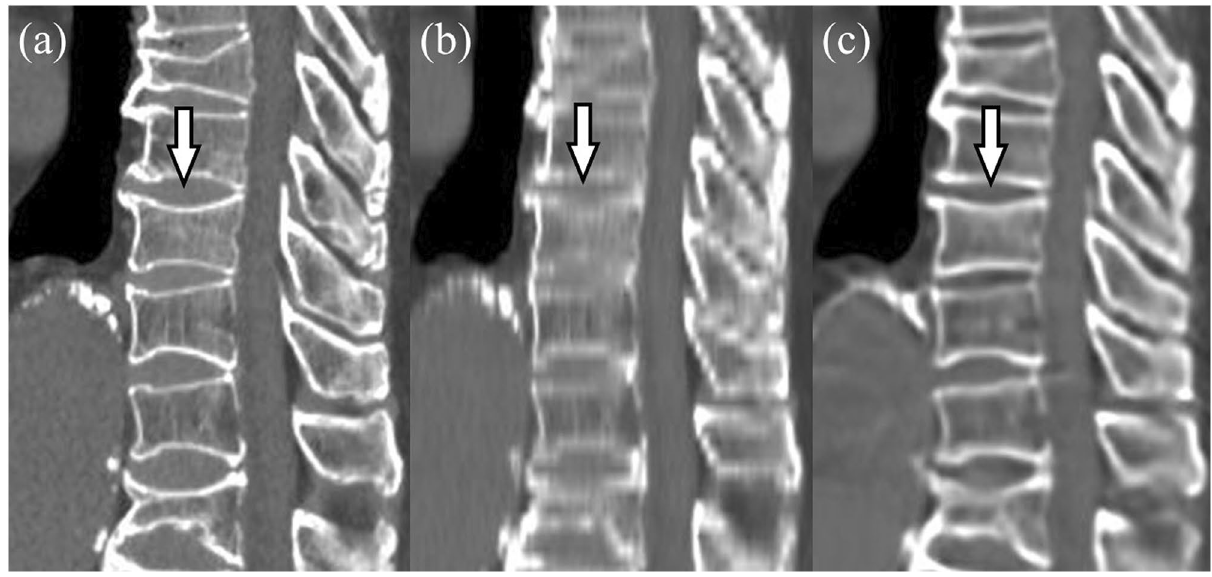
Figure 4. Sagittal reformatted images reconstructed from 1-mm-thick images ( a ), 4-mm-thick images ( b ), and virtual thin-slice images ( c ). Multiple compression fractures are seen in the thoracic and lumbar spine. The fracture of the 10th thoracic vertebra can be seen on the reconstruction from 1-mm-thick images (arrow), and is also identifiable on that from the 4-mm-thick images. However, it is barely visible on that from the virtual thin- slice image, and is therefore difficult to diagnose.